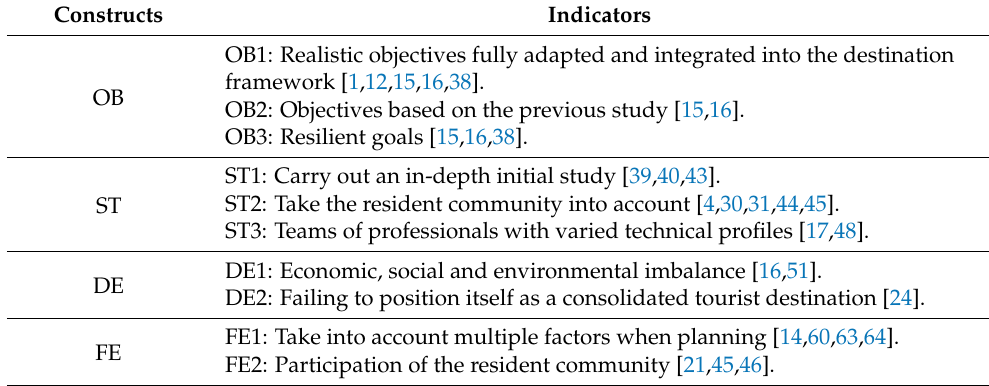
Table 3. Constructs and